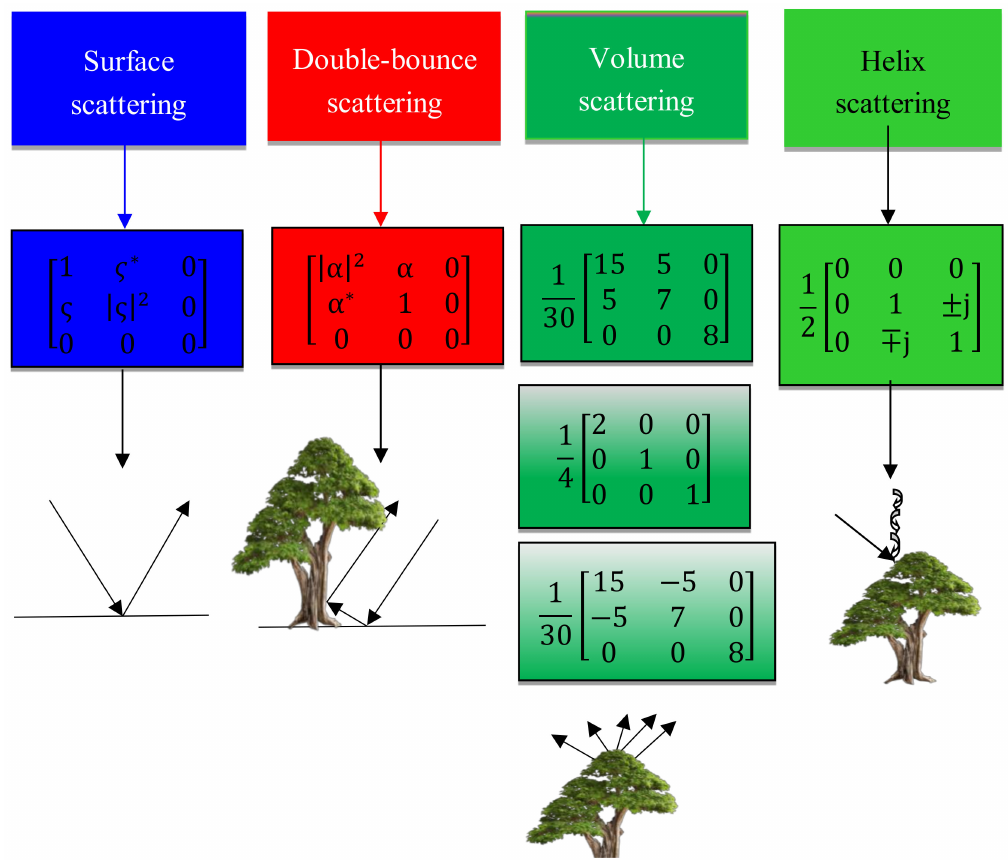
Figure 6. Scattering elements of the Yamaguchi four component decomposition